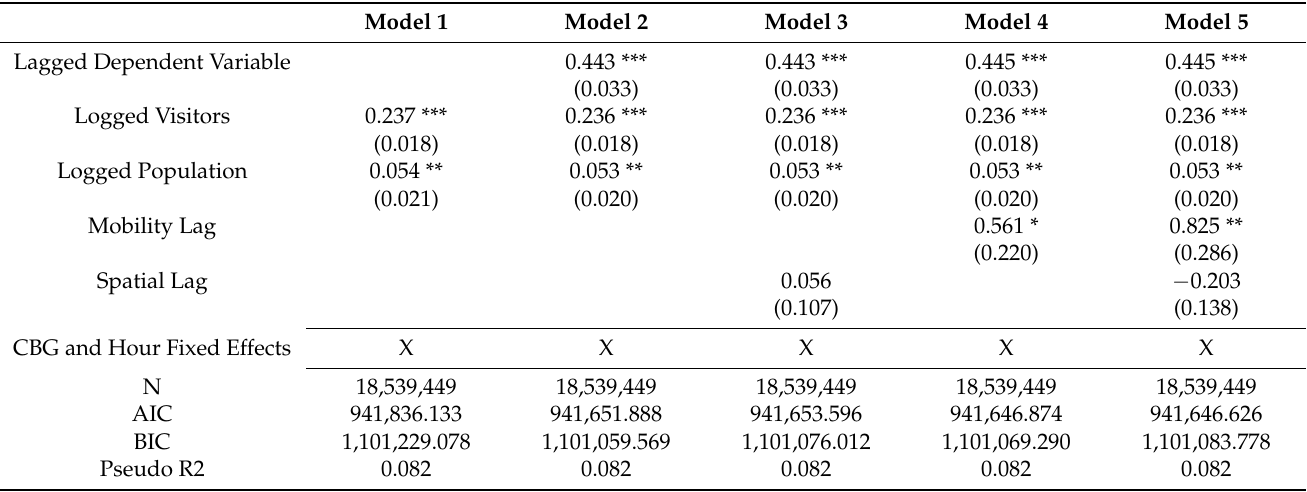
Table 6. Chicago Hourly Violent Crime